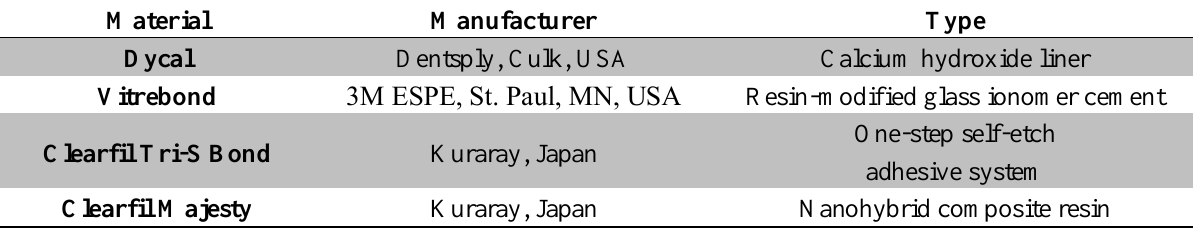
Table 1. The materials tested in the present study.